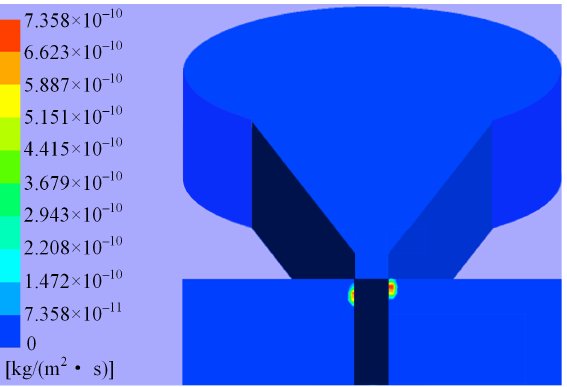
Figure 15. Erosion rates close to the jet